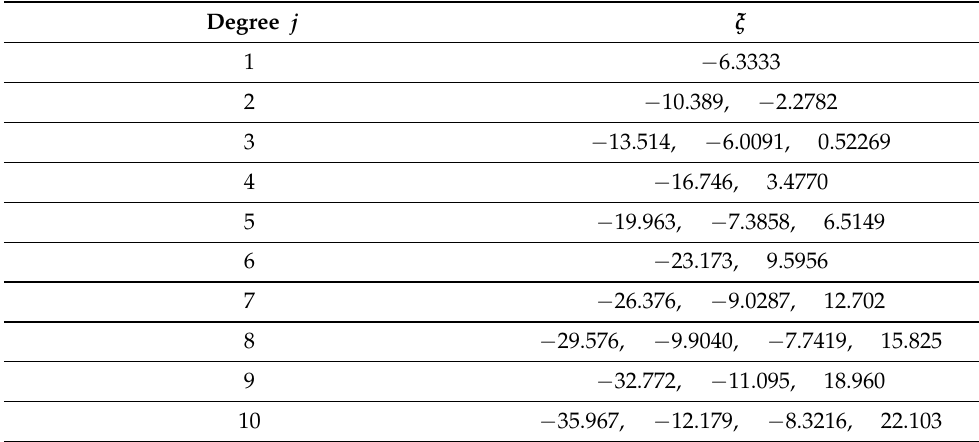
( 5, c ) ( ξ ,3,5; − 5; − 2 ) = j